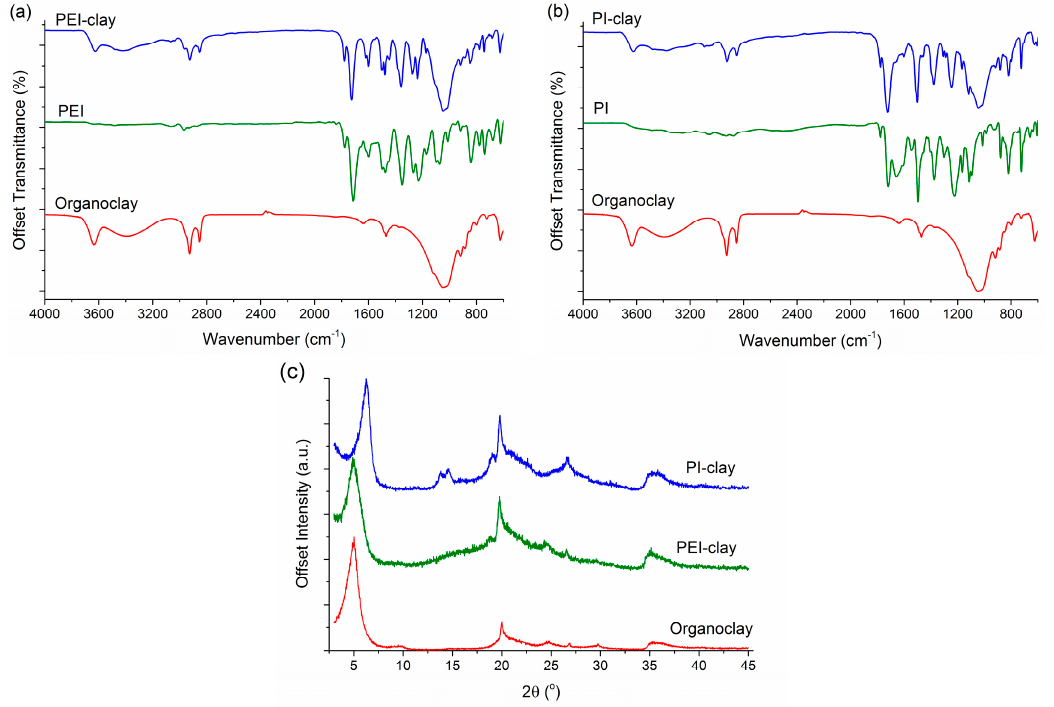
Figure 2. FTIR spectra of ( a ) organoclay, PEI, and PEI-coated clay; ( b ) organoclay, PI, and PI-coated clay; and ( c ) XRD patterns of organoclay, PEI- and PI-coated clay powders.